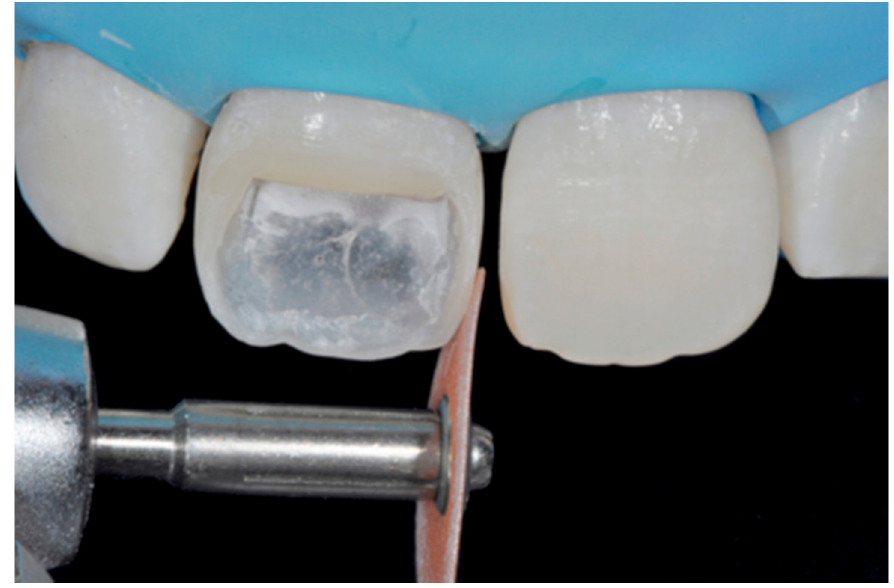
Figure 7. External frame profile is modified with abrasive discs. Reprinted from Restauri diretti nei settori anteriori, G. Paolone, S. Scolavino, © 2021, with permission from Quintessence Publishing Italy.